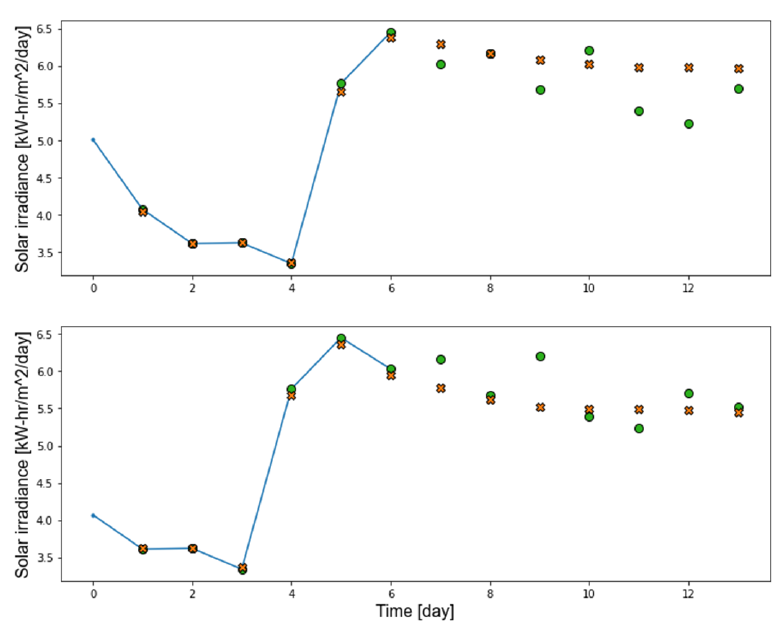
Figure 12. Example of 0th patch 7-day-ahead prediction. The results show that the smallest average solar irradiance prediction error is about 131.49326 Wh/m 2 /day, which is a good result when the average daily solar irradiance is 5.3070946 kWh/m 2 /day (the error is less than 2.5% of the mean solar irradiance). The MAPE error results are presented in Table 1. Table 1. Mean absolute percentage error results.